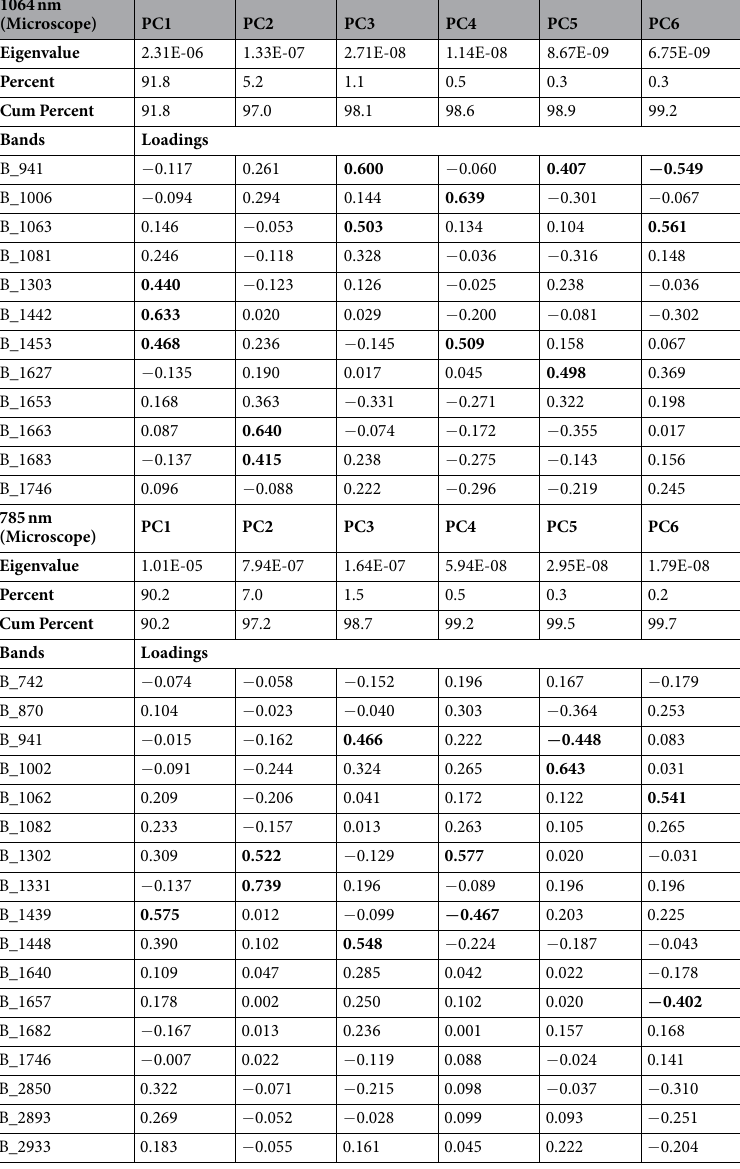
Table 2. Principal component analysis (PCA) extracts 6 eigenvectors accounting for > 99% of the variance in 12 bands from the 1064 nm system and 17 bands from the785 nm device. Eigenvector loadings > 0.4 ( + or − ) for each PC appear in